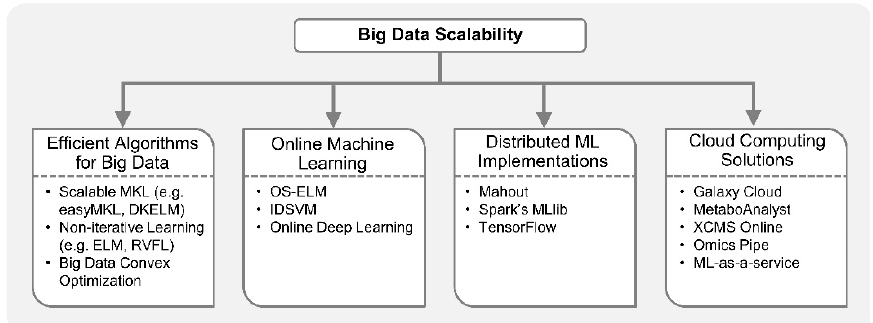
Figure 5. Large-scale machine learning. ML-based integrative analysis can be performed at large-scale by utilizing computationally efficient algorithms proposed for big data, online training algorithms, distributed data processing and computing frameworks, or cloud computing-based solutions. Efficient computational approaches tailored for big data include non-iterative neural networks (e.g., extreme learning machine (ELM) and random vector functional link (RVFL)), scalable multiple kernel learning (MKL) methods (e.g., easyMKL and dual-layer kernel ELM (DKELM)), convex optimization for big data, etc. Online machine learning algorithms including online sequential extreme learning machine (OS-ELM), incremental decremental support vector machine (IDSVM), and online deep learning are attractive for big data applications as they incrementally update the model with small chunks of data, instead of loading entire data in memory and learning all at once. In addition, ML algorithms can now be massively parallelized over a cluster of CPUs or graphics processing units (GPUs) using Spark’s MLlib, Apache Mahout, and Google’s TensorFlow programming frameworks. Cloud computing-based bioinformatics platforms including Galaxy Cloud, MetaboAnalyst, XCMS online, and Omics pipe are useful resources for multi-omics exploratory data analysis (EDA) and ML. Moreover, machine learning-as-a-service is being offered by leading commercial cloud service providers like Amazon, Google, Microsoft and IBM, which can be utilized for implementing ML-based analytical pipelines in large-scale multi-omics